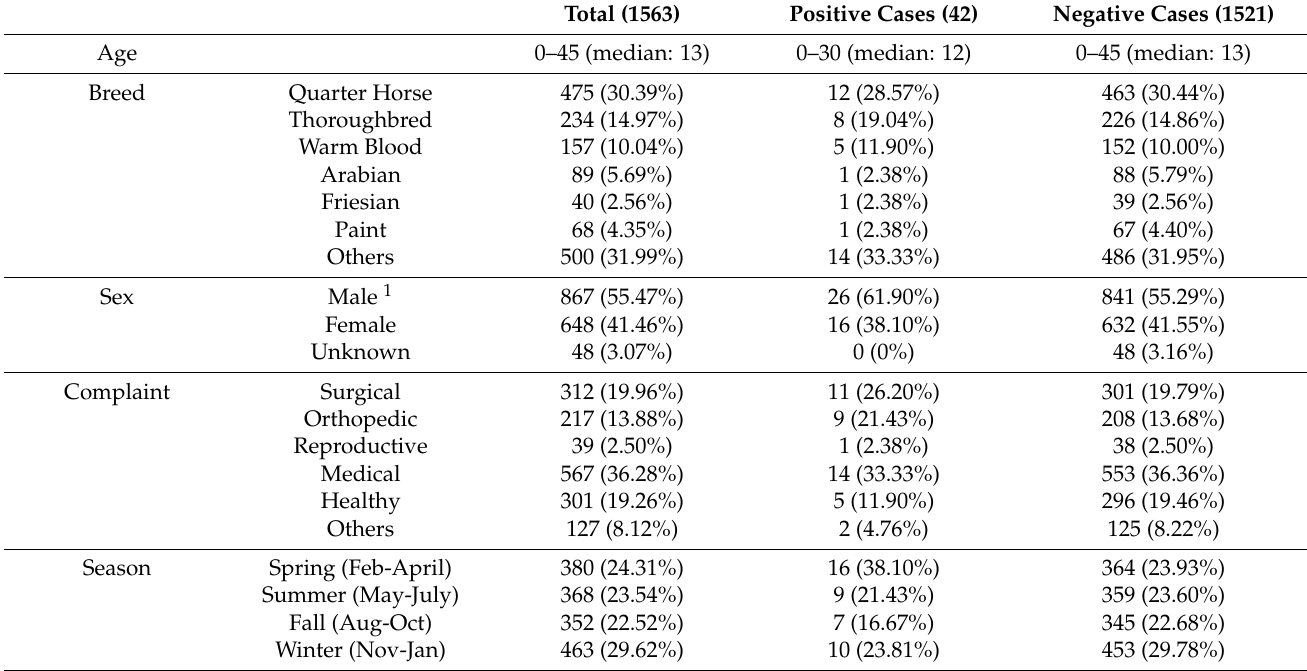
Table 1. Signalment (age, breed, sex), presenting complaint, and season of presentation in 1186 equids tested for antibodies against